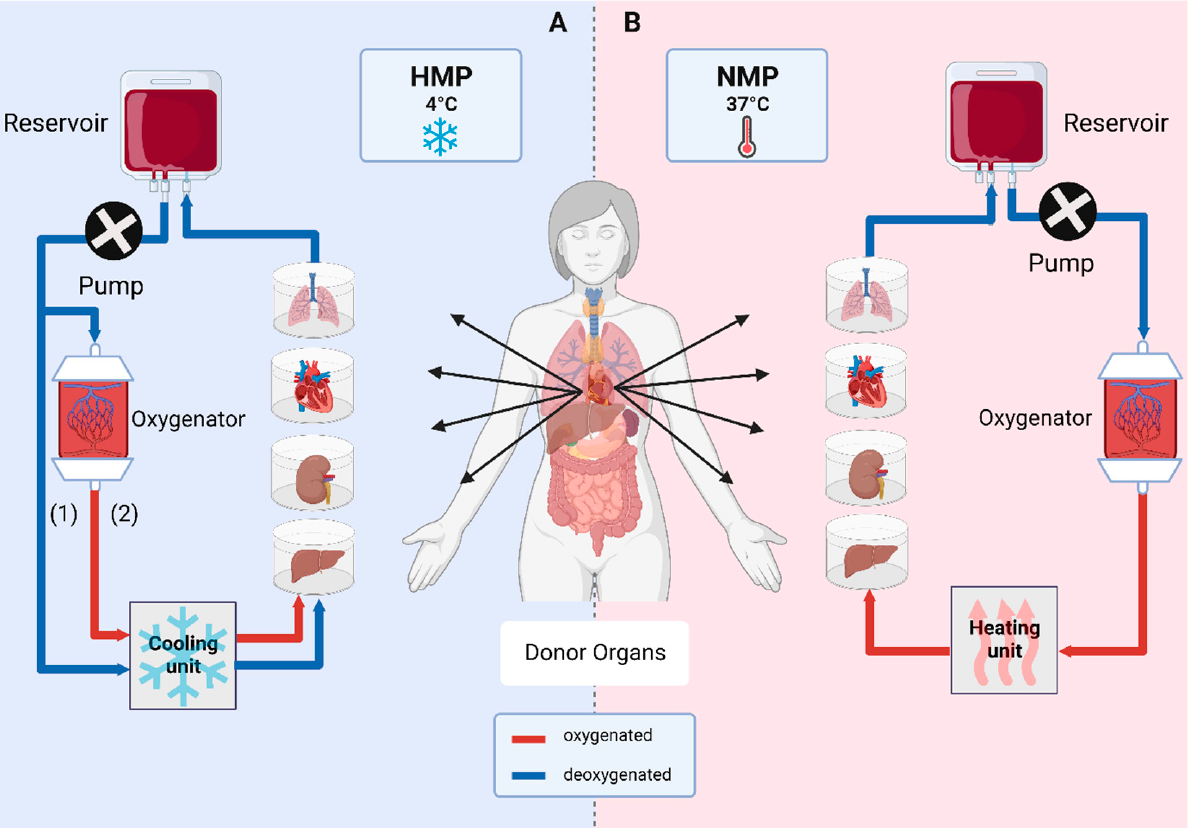
Figure 2. Ex vivo organ machine perfusion. Main vessels of an organ are cannulated and constantly perfused. (A) Hypothermic machine perfusion (HMP) is performed at 4°C and can either take place without oxygenation (1) or with incorporation of an oxygenator (2), known as hypothermic oxygenated machine perfusion (HOPE). (B) Normothermic machine perfusion (NMP) is performed at 37°C with oxygenated perfusion solutions under close-to-physiological conditions [3].